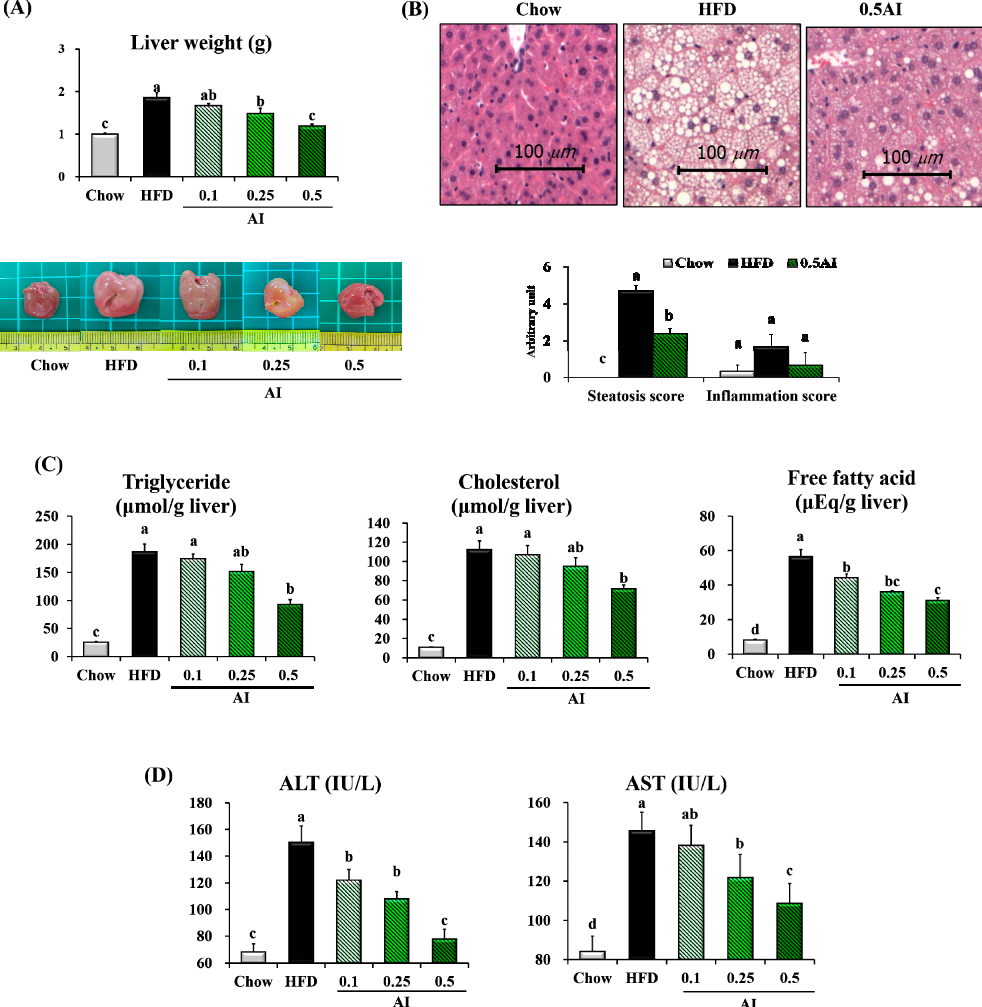
Figure 3. AI alleviates hepatic steatosis in HFD-fed mice. ( A ) Liver weights and gross morphology; ( B ) representative images of H&E-stained sections of liver (scale bar = 100 µ m) and scores for hepatic steatosis and inflammation; ( C ) hepatic levels of triglyceride, cholesterol, and free fatty acid; ( D ) plasma aminotransferase (ALT) and aspartate aminotransferase (AST) activities; Data are the mean ± SEM of n = 8. Statistical analysis was performed using one-way ANOVA and analyzed further by Duncan’s multiple range test. Different letters above the bars indicate significant differences among experimental groups ( p <